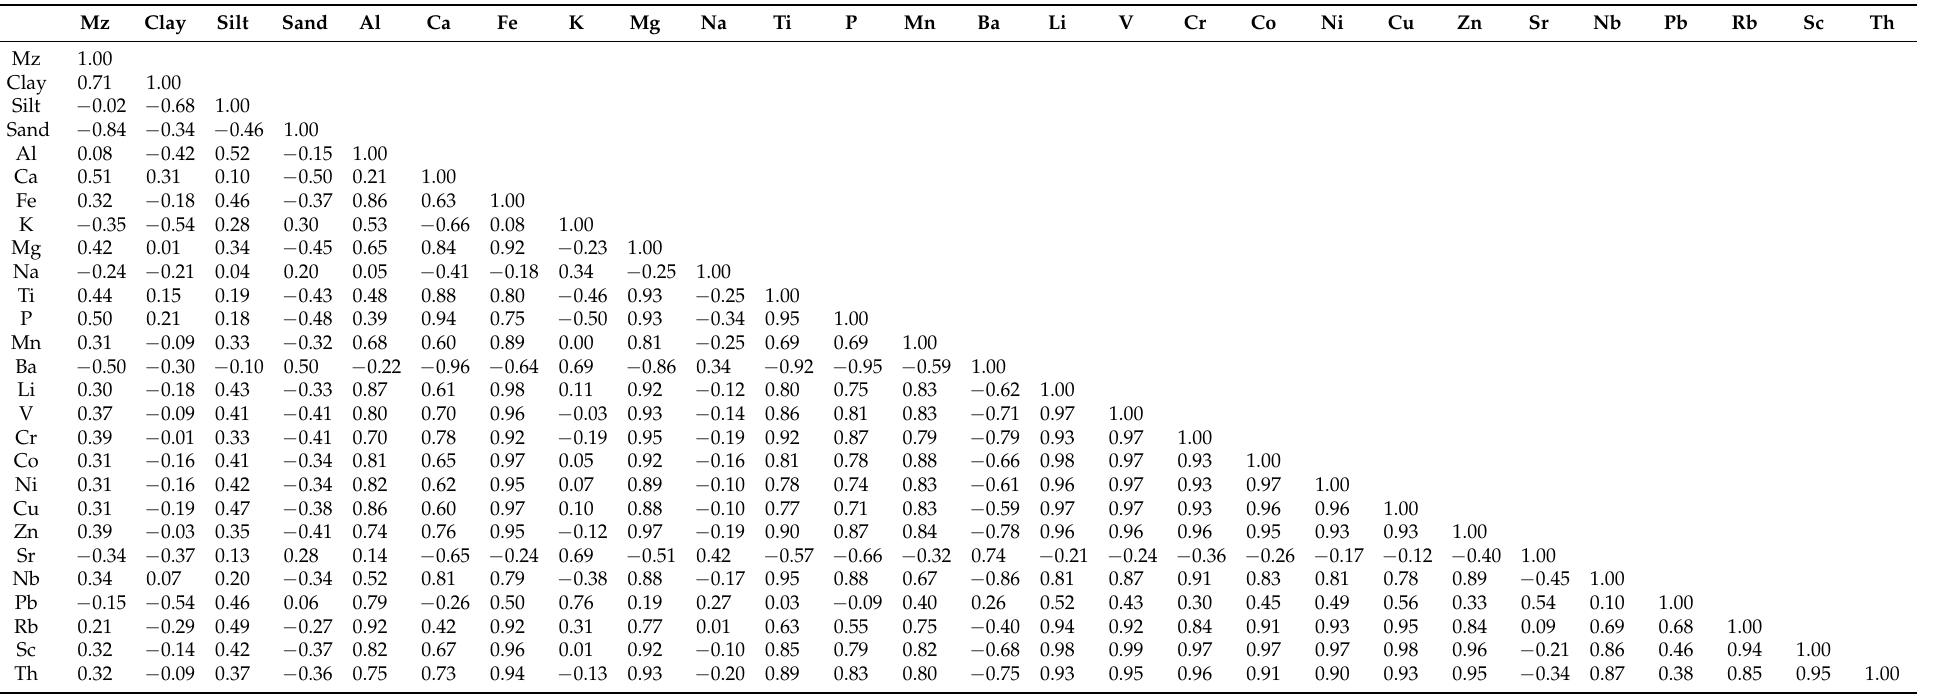
Table 4. Correlation coefficient between the element contents and Grain size parameter (n =